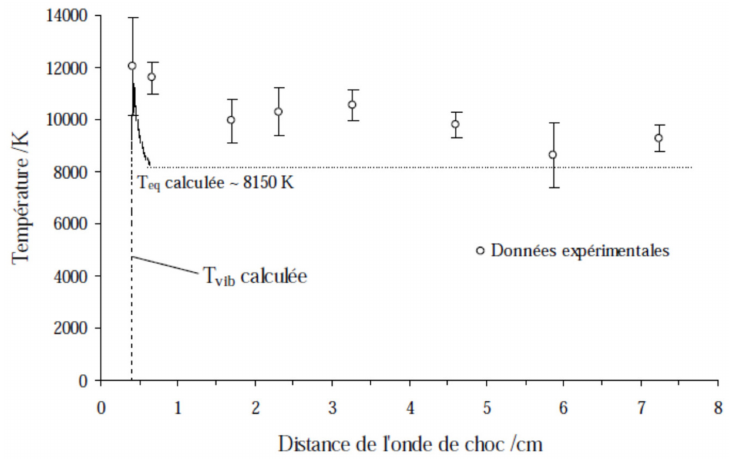
Figure 53. Experimental and predicted vibrational temperature for Case 1 of Table 5 as function as shock distance (from